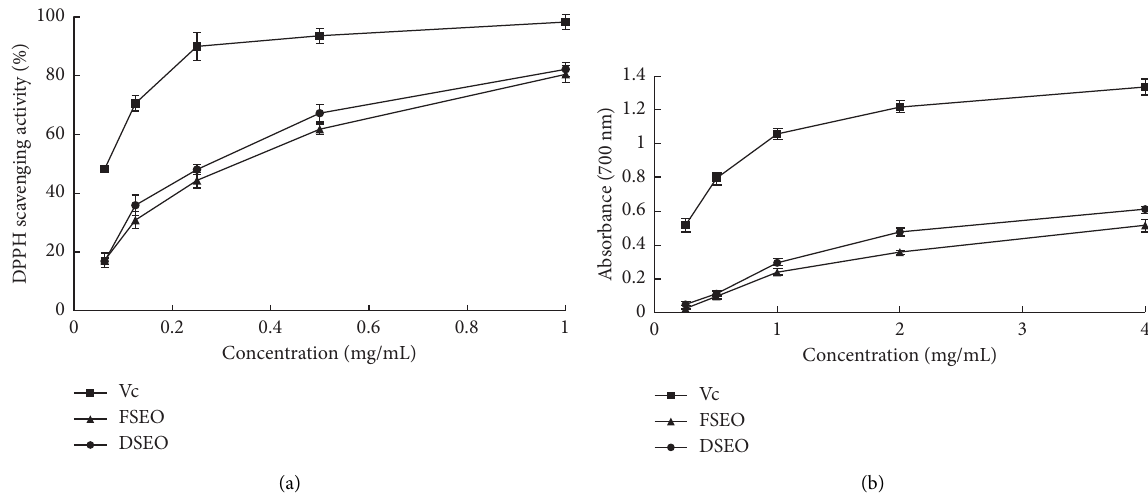
Figure 3: Antioxidant activities of fresh and dried SEOs. Notes . (a) DPPH radical scavenging activity of FSEO and DSEO; (b) ferric reducing power of FSEO and DSEO. FSEO: essential oil from fresh S. rugosoannulata ; DSEO: essential oil from dried S. rugosoannulata ; Vc: ascorbic